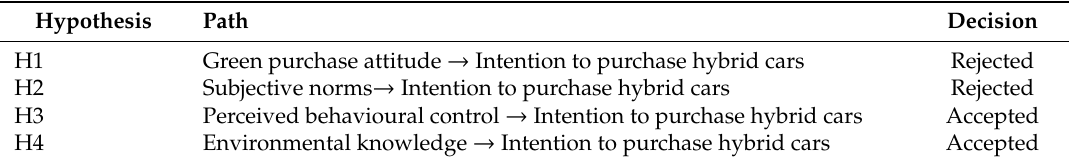
Table 6. Summary of hypotheses